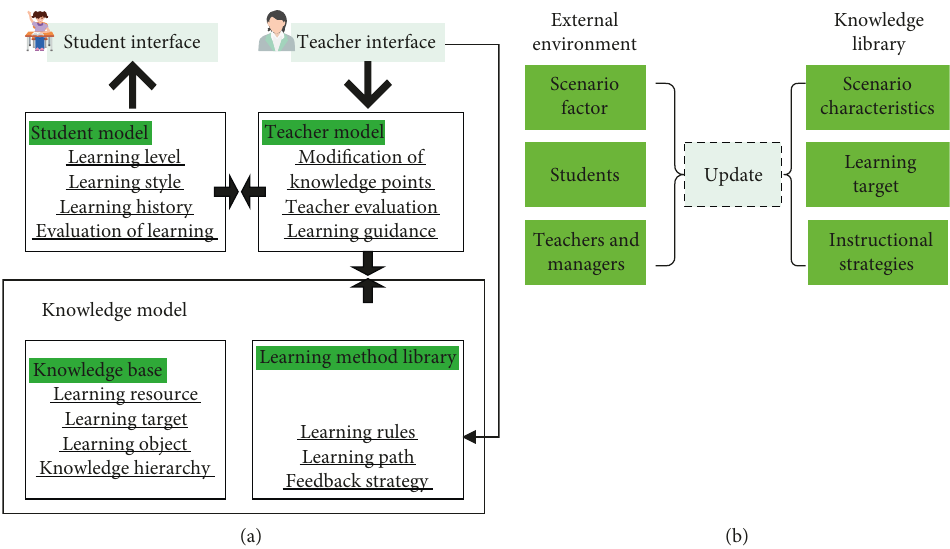
Figure 13: Structure of intelligent English teaching system. (a) System module structure and (b) knowledge base storage structure.